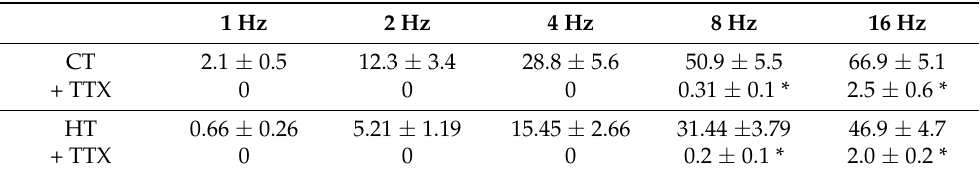
Table 2. EFS-induced contraction after preincubation with 0.1 µ mol/L TTX in mesenteric segments from CT and HT